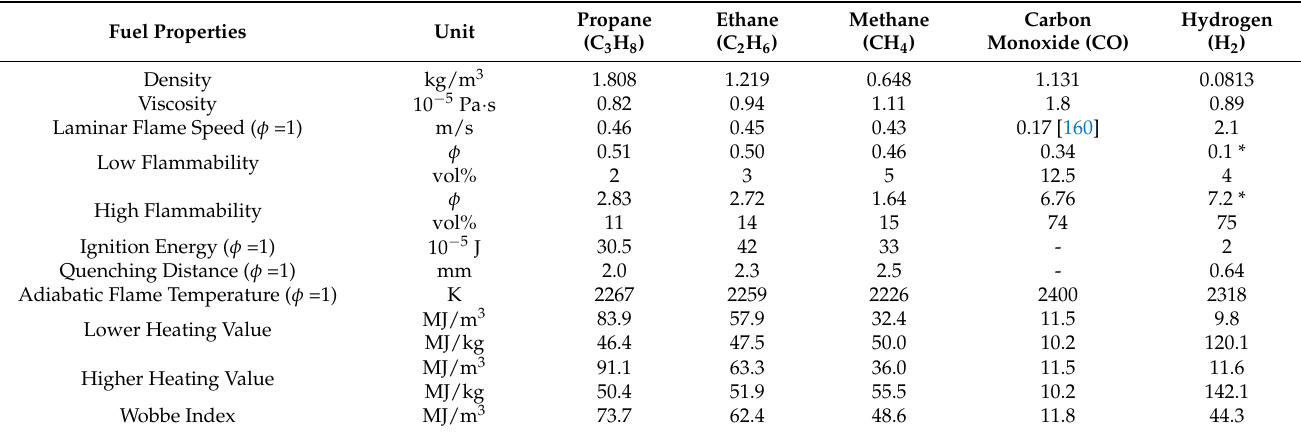
Table 12. Property comparison among common residential fuels (at 298.15 K and 1 atm).